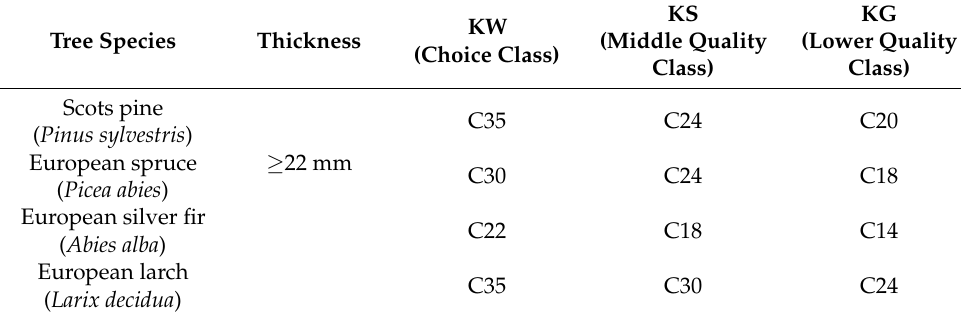
Table 2. The relationship between grading classes (PN-D-94021) [47] of domestic structural timber and grading strength classes C (PN-EN 338)